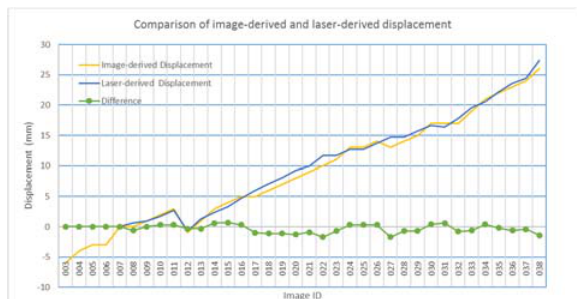
Figure 7. Comparison of image-derived and laser-derived displacements.